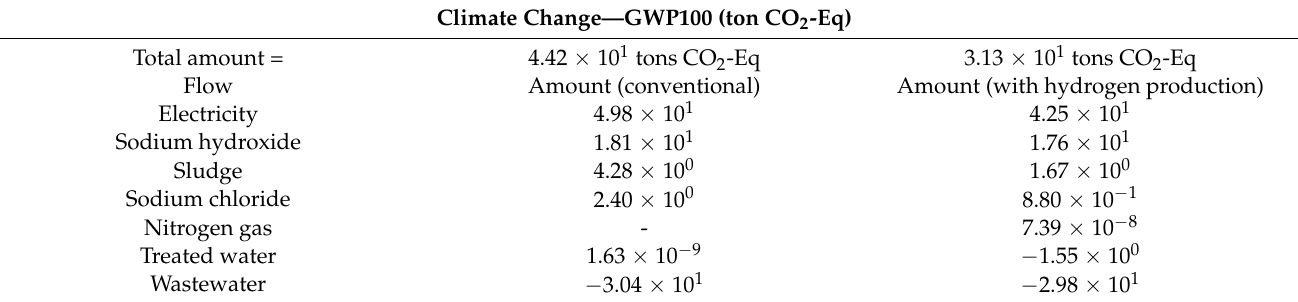
Table 8. Climate change assessment before and after producing bio-hydrogen gas.